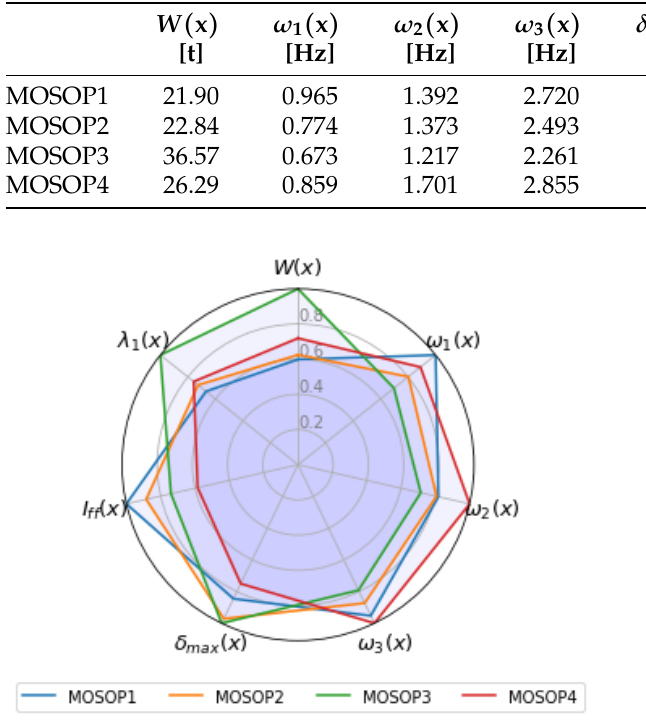
Table 3. Design attributes of each extracted solution.